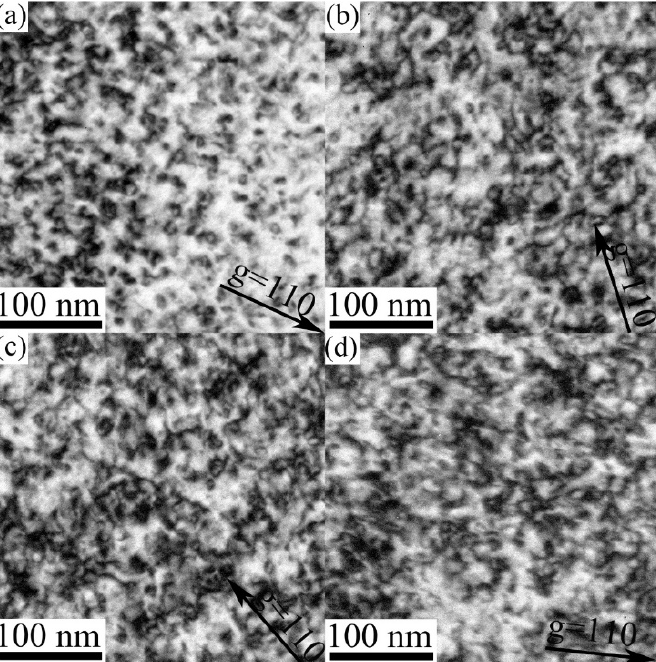
Figure 4. Bright field TEM micrographs of Y − FeCrAl alloy in the 500–700 nm depth under the condition of [001] pole, g = − 110, the damage dose is ( a ) 1.0 dpa ( b ) 2.5 dpa, ( c ) 5.0 dpa, ( d ) 10.0 dpa. The size and density of dislocation loops in the observed region (500–700 nm) were counted, and the size distribution results of dislocation loops was obtained as shown in Figures 5 and 6. Only defects above 5 nm were counted in the sample to avoid the error caused by FIB.